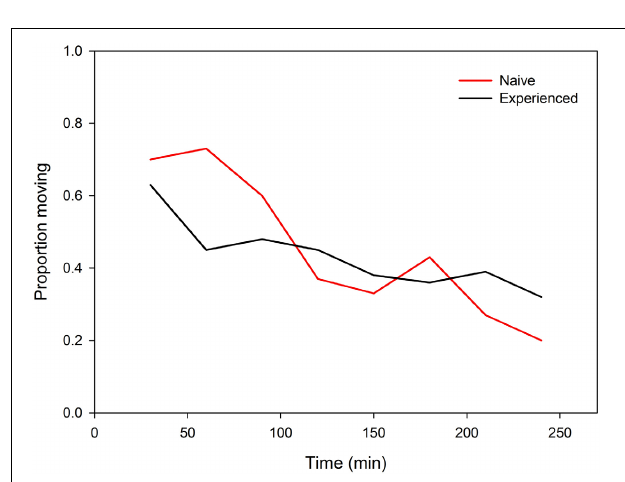
FIGURE 4 | Activity (proportion moving) of predator-naïve and -experienced spider mite females given a choice between two connected leaf discs, one with and one without predatory mite cues, over